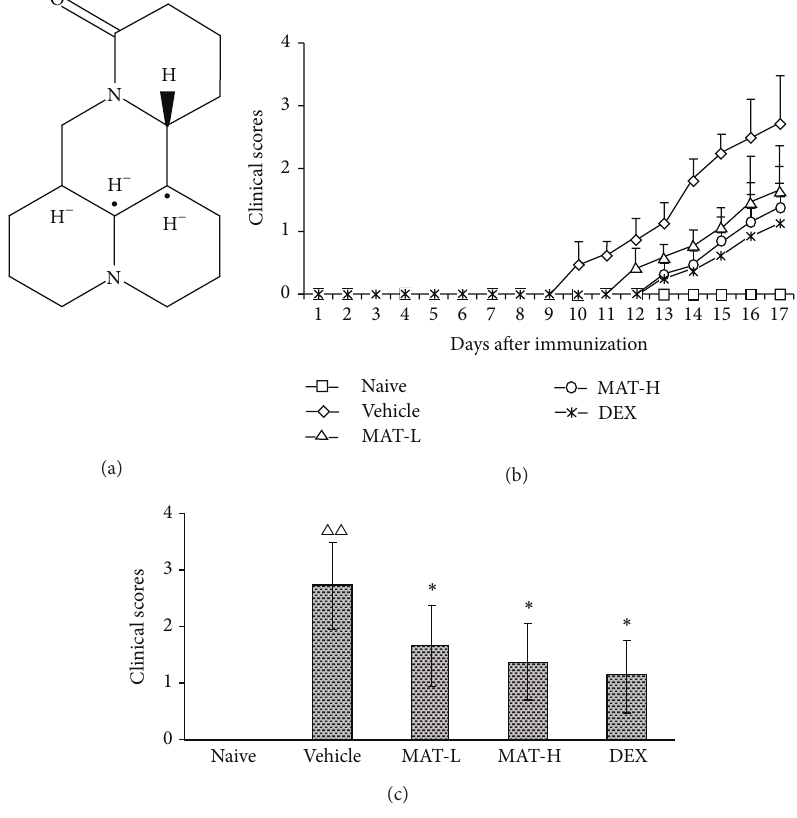
Figure 1: MAT reduces clinical signs of EAE. (a) Structure of MAT. (b) Effect-versus-time curves of MAT effects on EAE. Clinical EAE was scored daily after immunization according to a 0–5 scale. (c) The mean maximum clinical scores are expressed as mean ± SD ( 𝑛 = 16 each group). △△ 𝑃 < 0.01 , compared to naive group; ∗ 𝑃 < 0.05 , compared to vehicle-treated